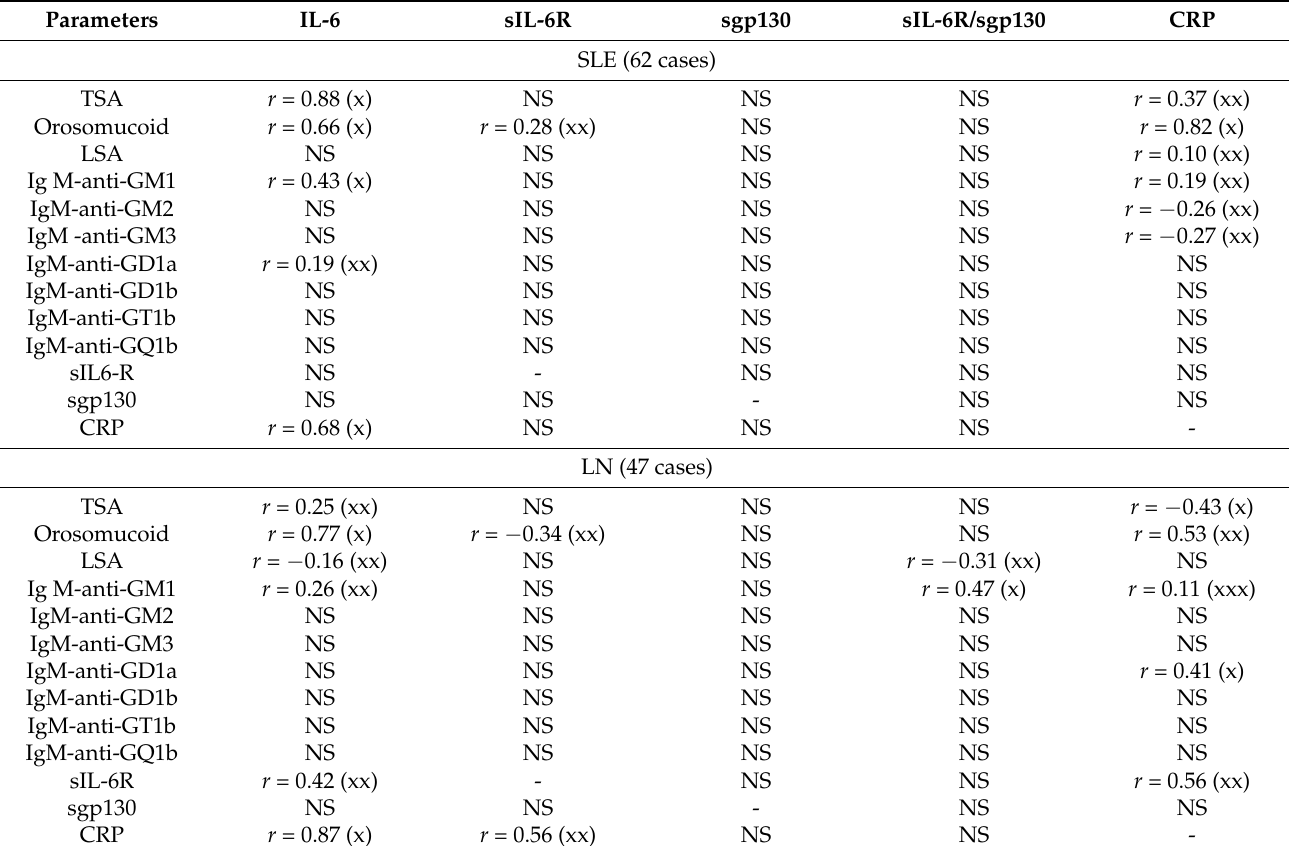
Table 6. Correlation analysis between glycoconjugates/antigangliosides and inflammatory markers.